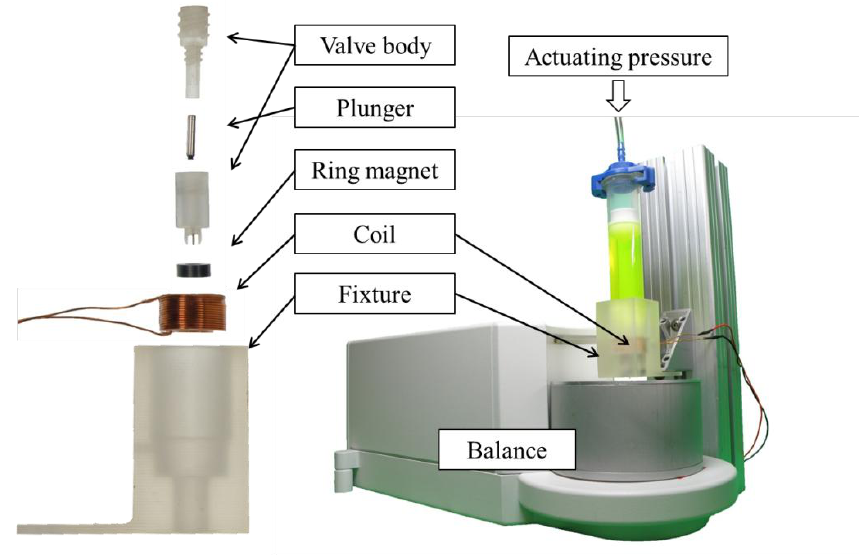
Figure 6. Left: exploded view of the dispensing valve and the fixture for the valve. Right: the gravimetric measurement set-up with a commercial polymer syringe as the liquid